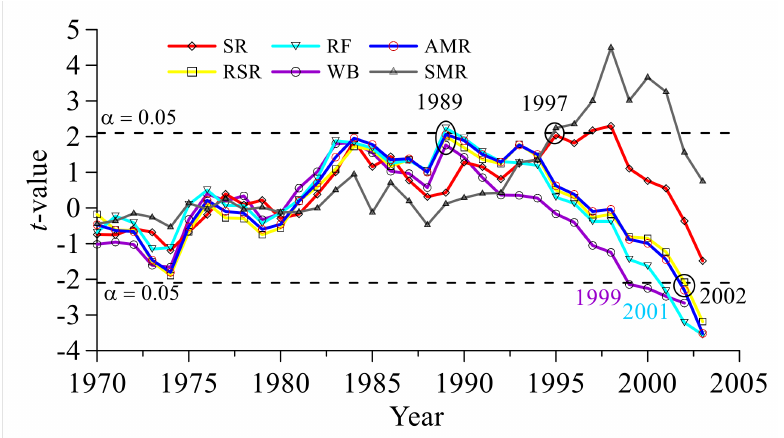
Figure 5. The moving t -test results of di ff erent runo ff